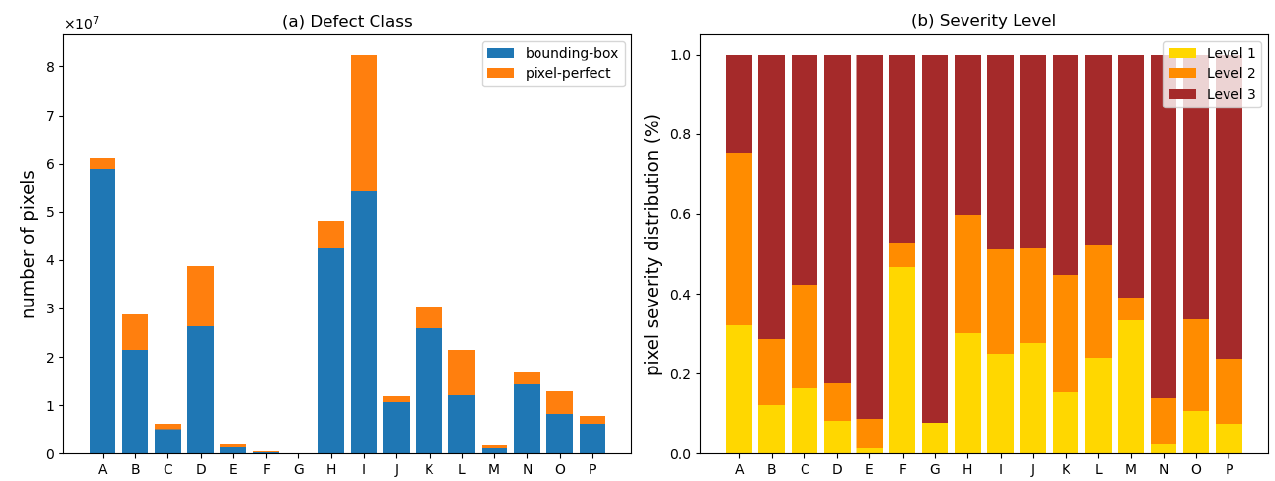
Figure 2. ( a ) Number of bounding-box and pixel-perfect labeled pixels per defect type. ( b ) Severity occurrence per defect type. It is clear that our dataset deals with two imbalance problems: both defect type (across dataset) and severity levels (per defect class) are